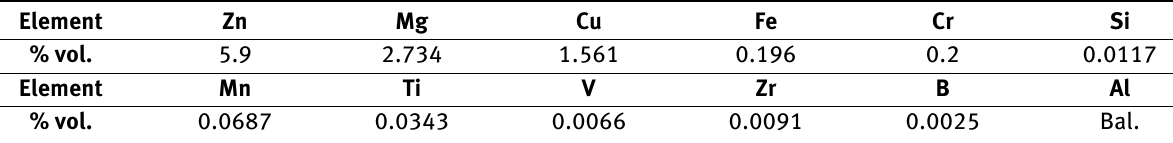
Table 1: The chemical composition of the AA7075 alloy used in the experimental studies. Element Zn Mg Cu Fe Cr Si % vol. Element Mn Ti V Zr B Al % vol. 0.0687